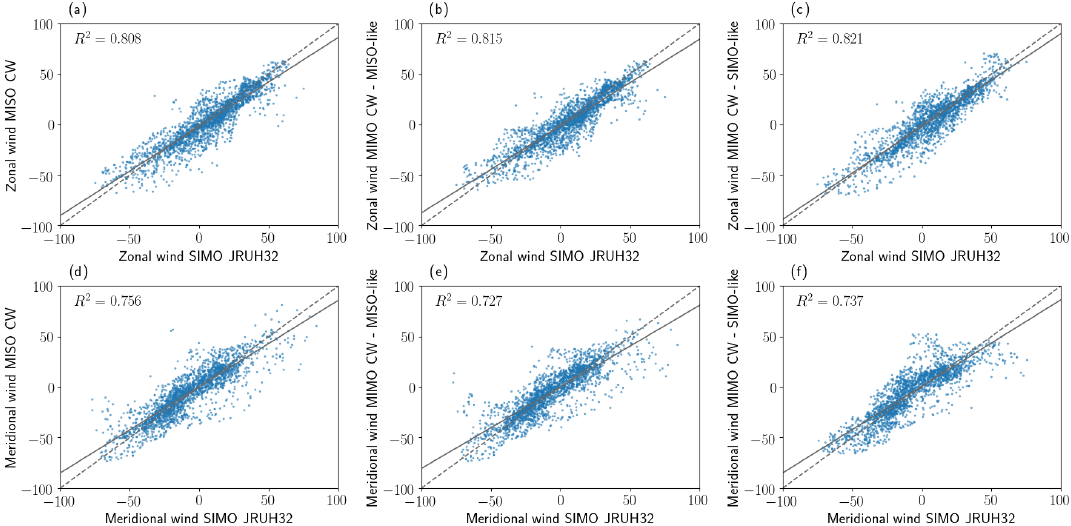
Figure 8. Scatterplots of zonal and meridional wind components using the monostatic values as a reference (SIMO-JRUH32) for MISO-CW (a, d) , MIMO-CW MISO-like (b, e) , and MIMO-CW SIMO-like (c, f) . The Pearson correlation coefficients are indicated on each scatterplot.